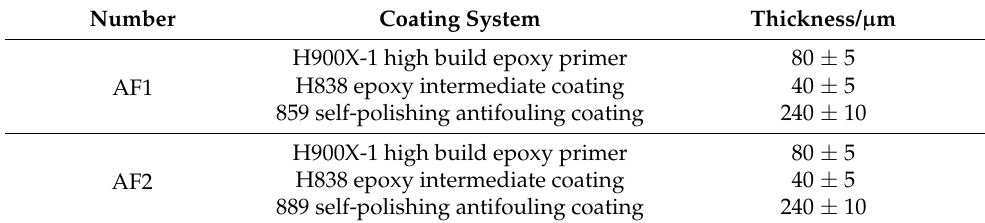
Table 1. Coating systems prepared and the film